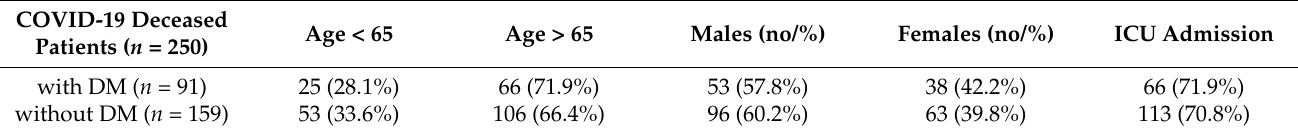
Table 5. Demographic characteristics in deceased patients with/without diabetes